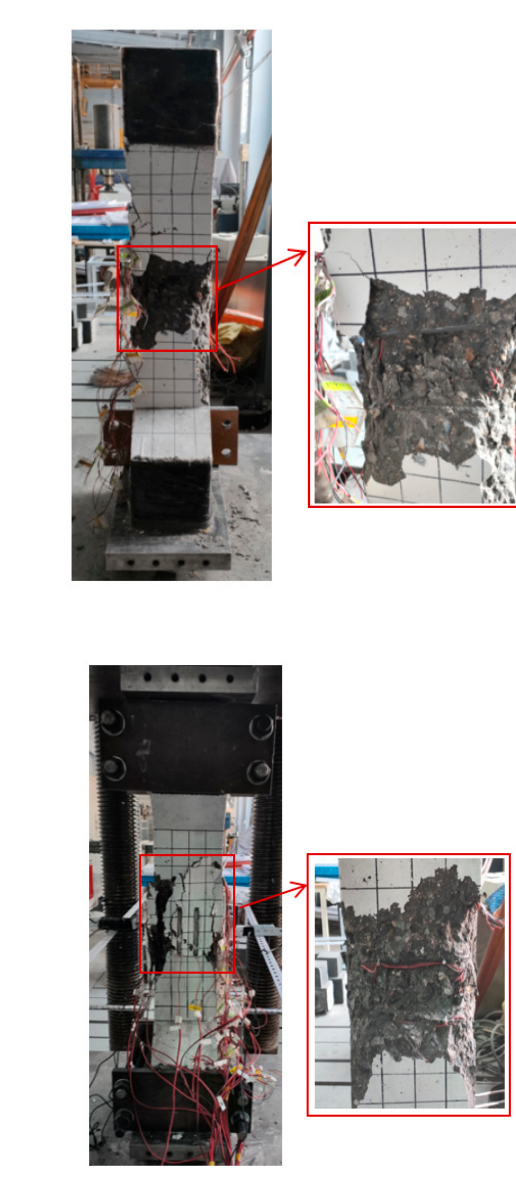
Figure 5. The failure mode of the columns under axial compression: ( a ) specimen A1; ( b ) specimen A2; ( c ) specimen A3; and ( d ) specimen A4 (C50).